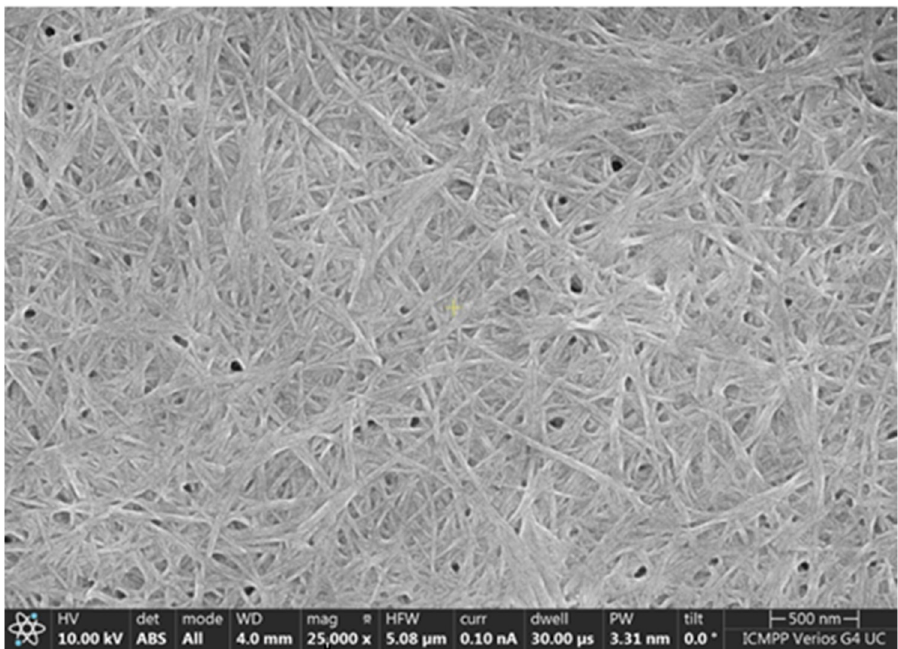
Figure 4. SEM image representing the active surface of SPCE/GPHOX-Pentapeptide.